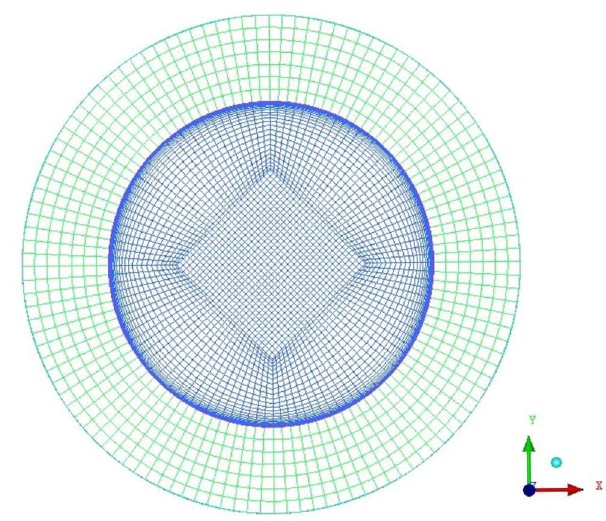
Fig. 4. Perpendicular section of the computational domain used in the